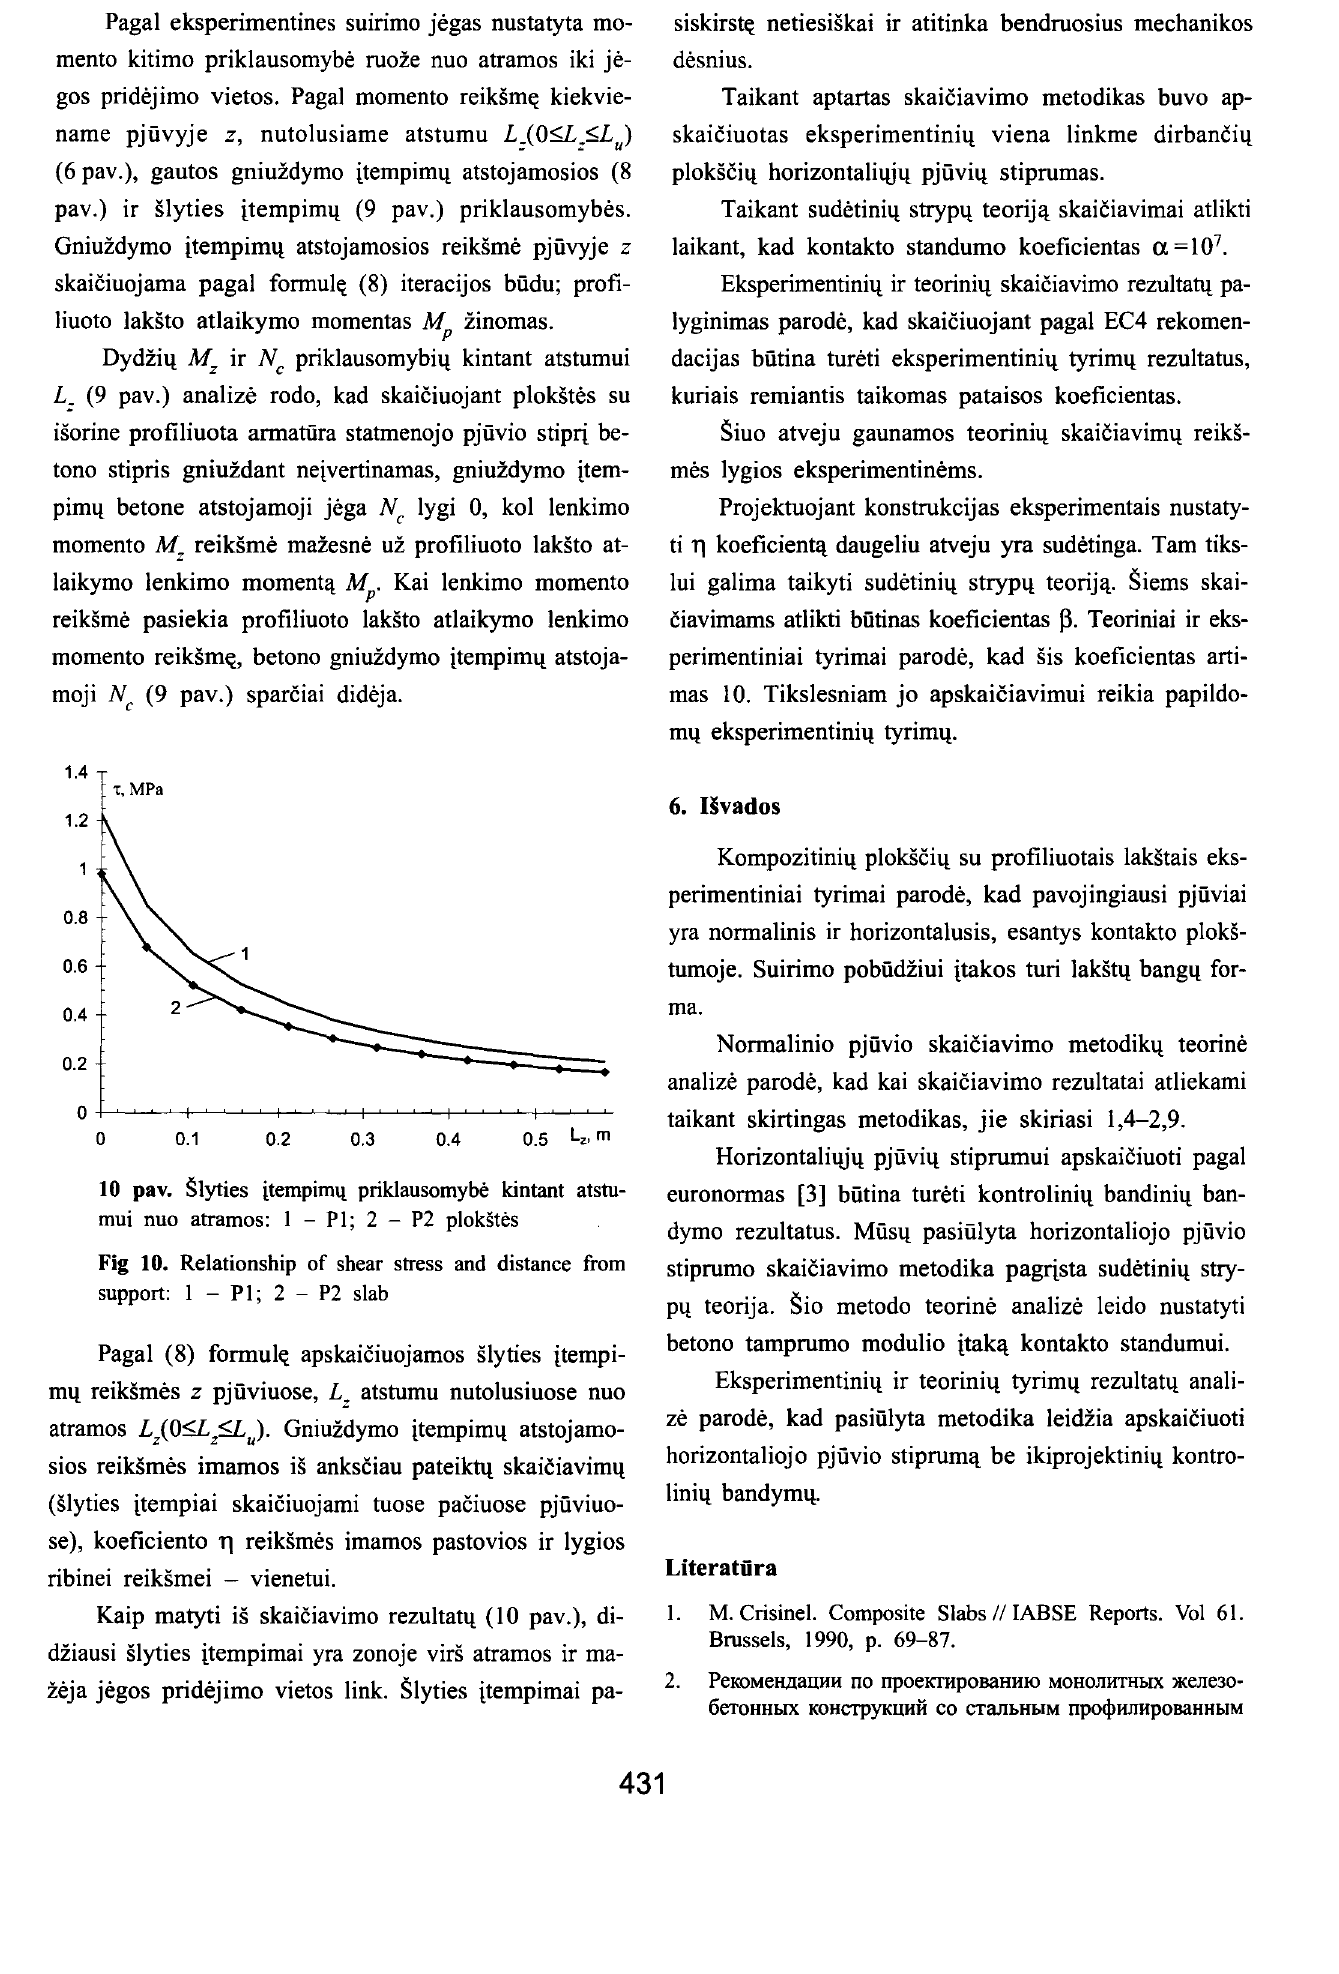
Fig 10. Relationship of shear stress and distance from support: 1 - P 1; 2 - P2